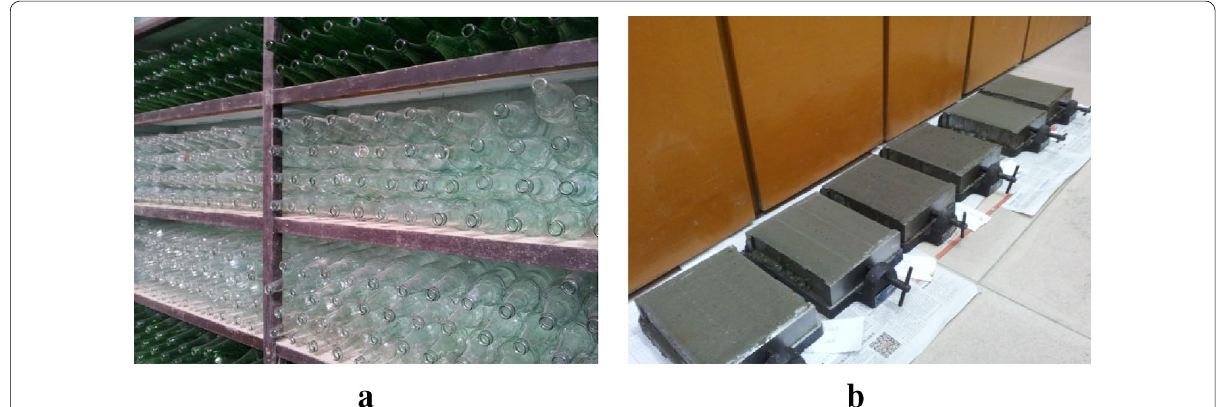
Fig. 1 Cement mortar incorporating waste glass powder for alkali–silica reaction expansion test. a Waste glass, b specimen after